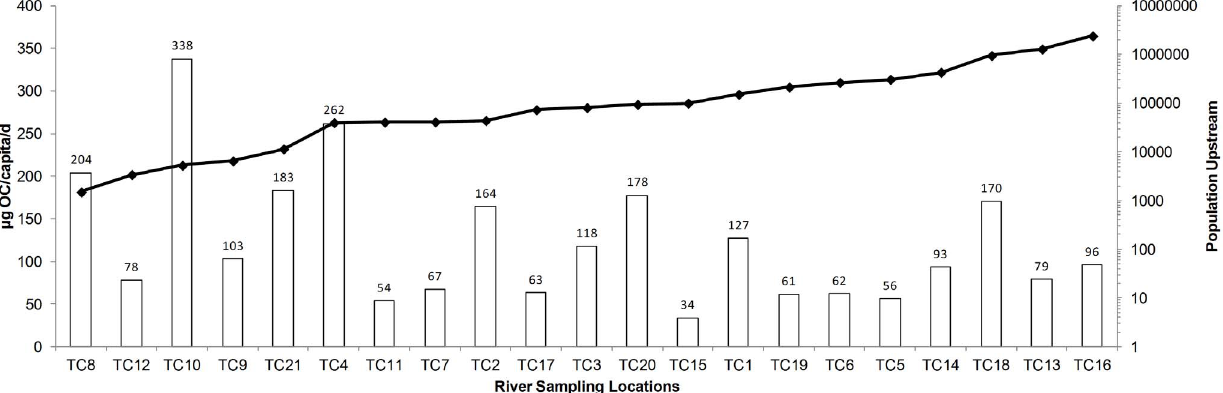
Figure 4. Mean load of oseltamivir (OC) per capita per day ( m g/cap/d) across all river sampling locations throughout November 2009 (intra-pandemic period). Triangles indicate the population upstream at that location.